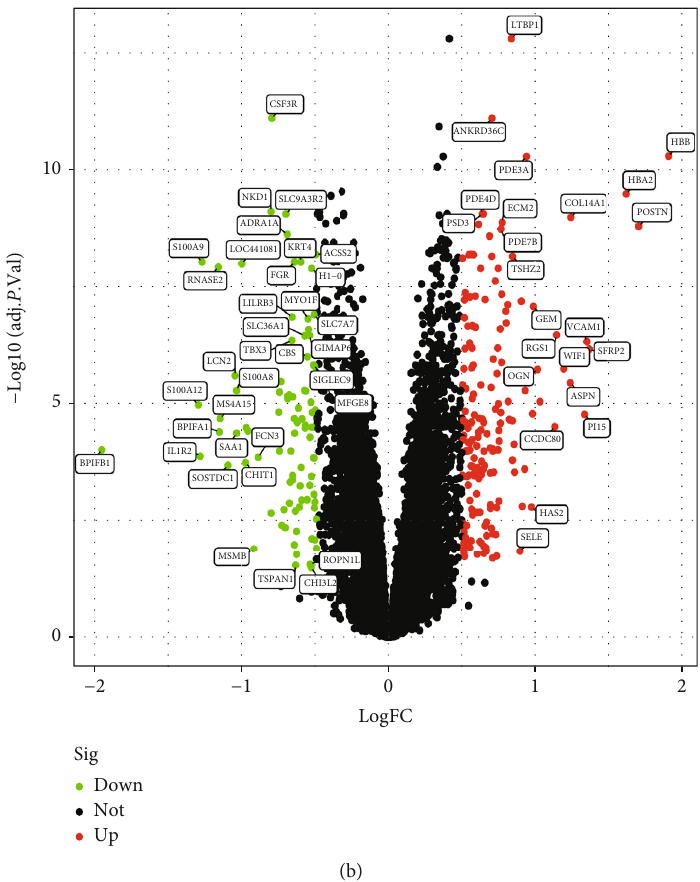
Figure 3: Visualizing the results of di ff erential genes. (a) Clustering heat map of the genes exhibiting signi fi cantly di ff erential expression PAH versus normal samples. Statistically signi fi cant DEGs were de fi ned as |log2Foldchange| > 0.5 and adjusted P value < 0.05. Cyan represents PAH samples; reddish-orange represents normal samples. (b) Volcano map of DEGs; red represents upregulated di ff erential genes, black represents no signi fi cant di ff erence in genes, and the green represents downregulated di ff erential genes. DEGs: di ff erentially expressed genes; PAH: pulmonary arterial